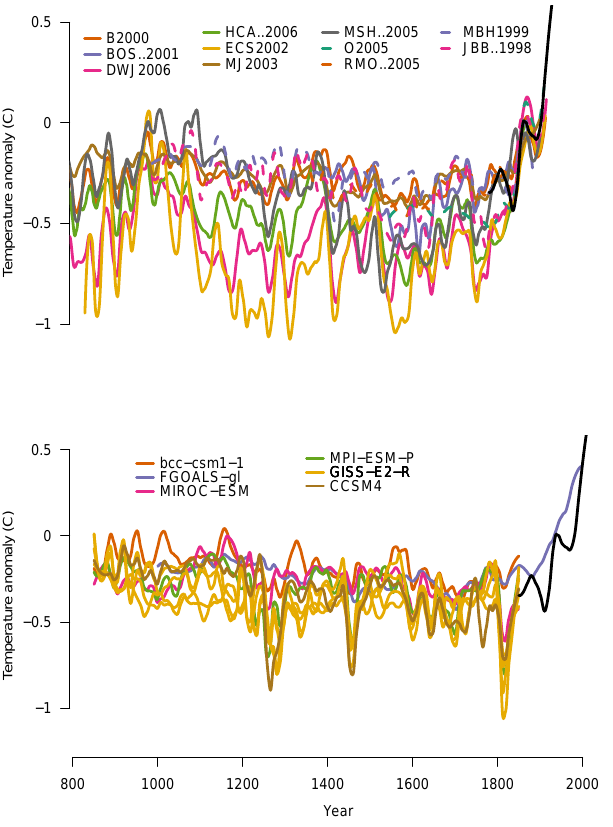
Fig. 1. Northern Hemisphere surface temperature estimates for the last millennium. Upper panel: recent proxy reconstructions (after figure 6.10 of Jansen et al., 2007). Lower panel: GCM simula- tions from CMIP5 (where possible (MIROC-ESM-P & GISS-E2-R) these have been corrected for drift by subtracting a linear trend fit- ted to their unforced parent experiment). In each case the black line shows instrumental observations (Brohan et al., 2006). Data used is listed in Table 1.